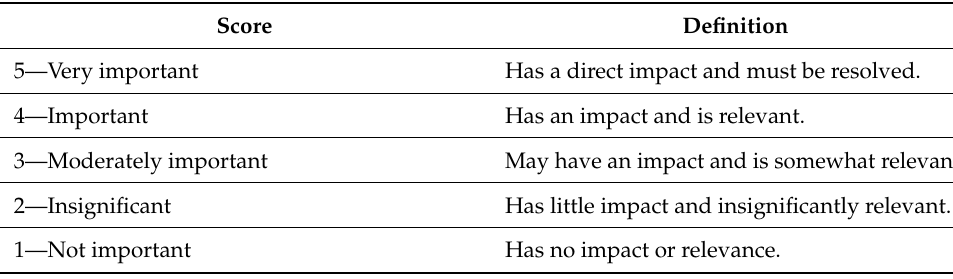
Table 2. Likert scale used in the